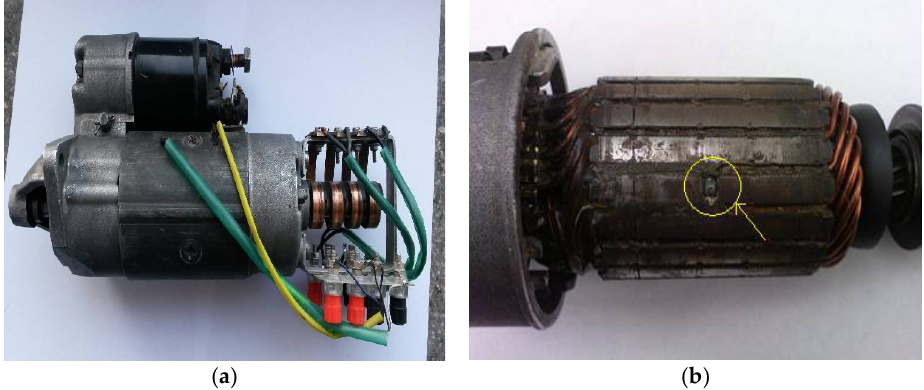
Figure 8. ( a ) View of the starter with fitted Hall sensors ( b ) and the Hall sensor placed on the rotor. The Hall sensor is stuck in the rotor tooth notch halfway through its length. Electric cables laid in the rotor grooves and in the rotor axis hollow are connected to four slip rings placed on the rotor axis, specially lengthened for this purpose.